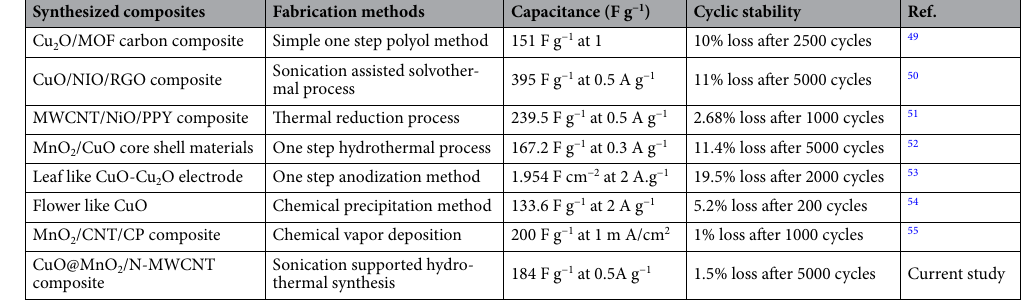
Table 1. Comparison of the electrochemical properties of the synthesized CuO@MnO 2 and CuO@MnO 2 /N- MWCNT composite with those of composite materials reported in the